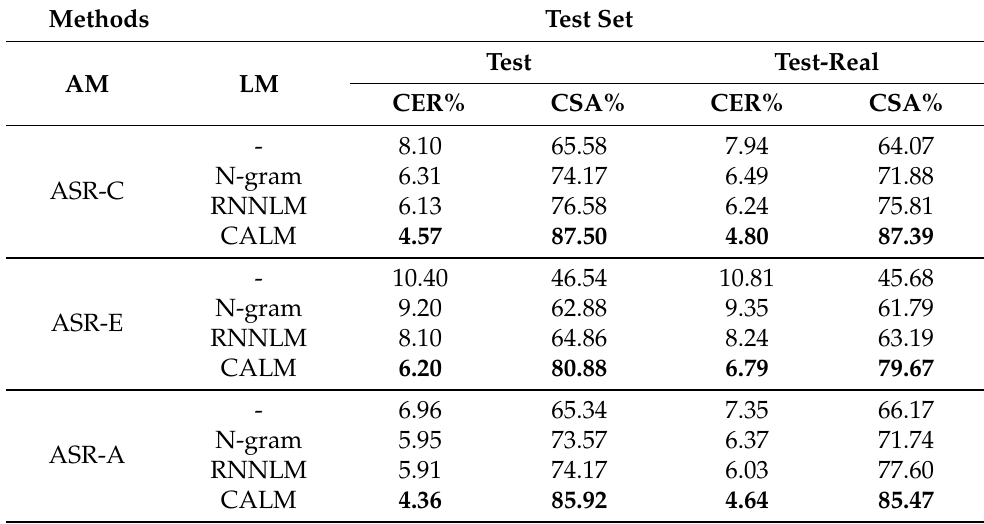
Table 2. Results of the decoding procedure.